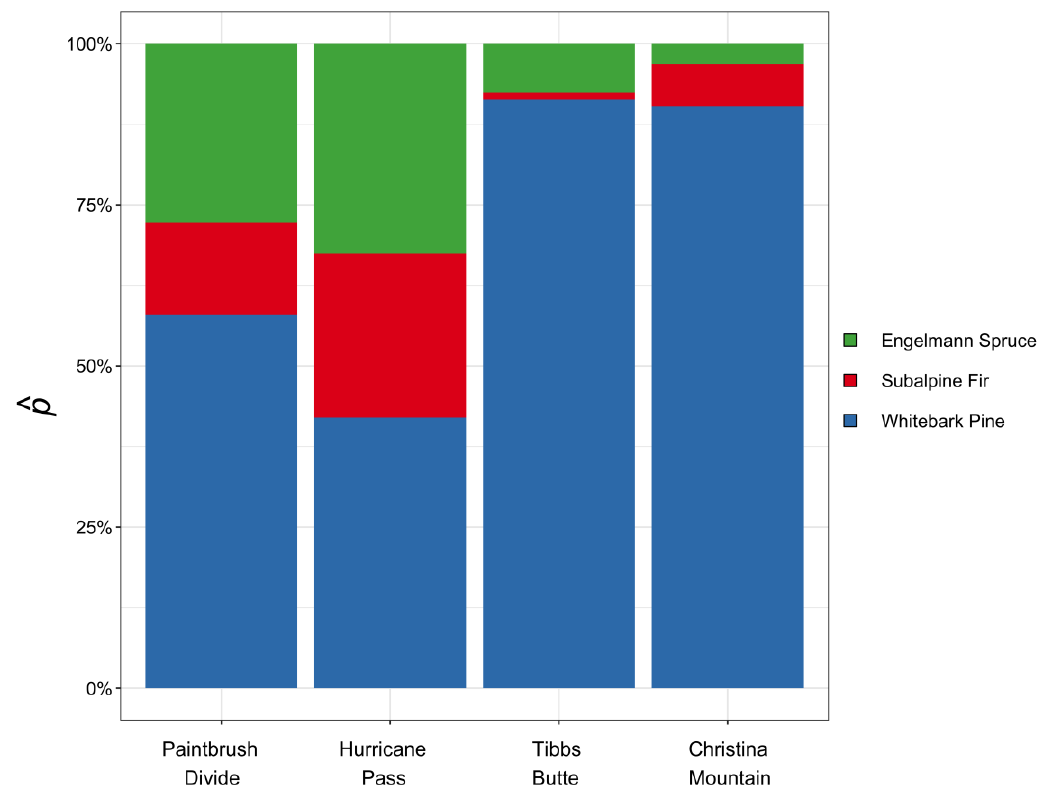
Figure 3. Overall community composition parameter estimates. Parameter estimates for species relative abundance by study area. The variability (i.e., 95% CIs) associated with each parameter estimate is provided in Table 4.